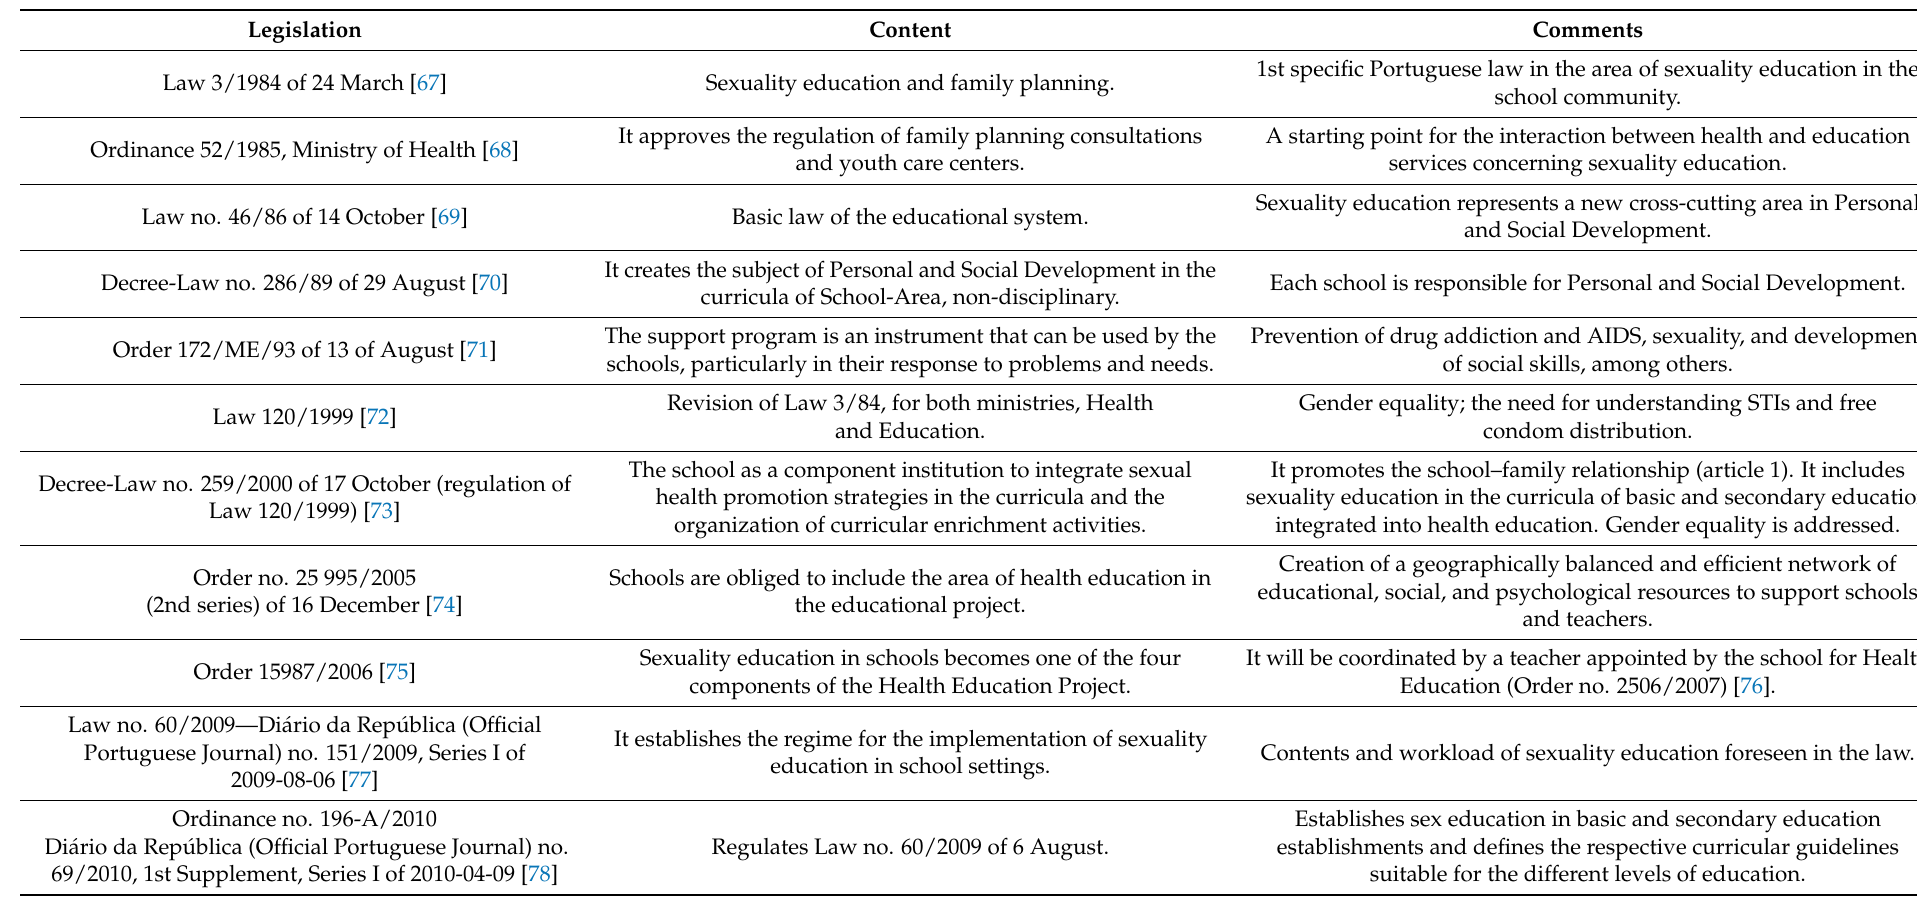
Table 4. Main legislation in